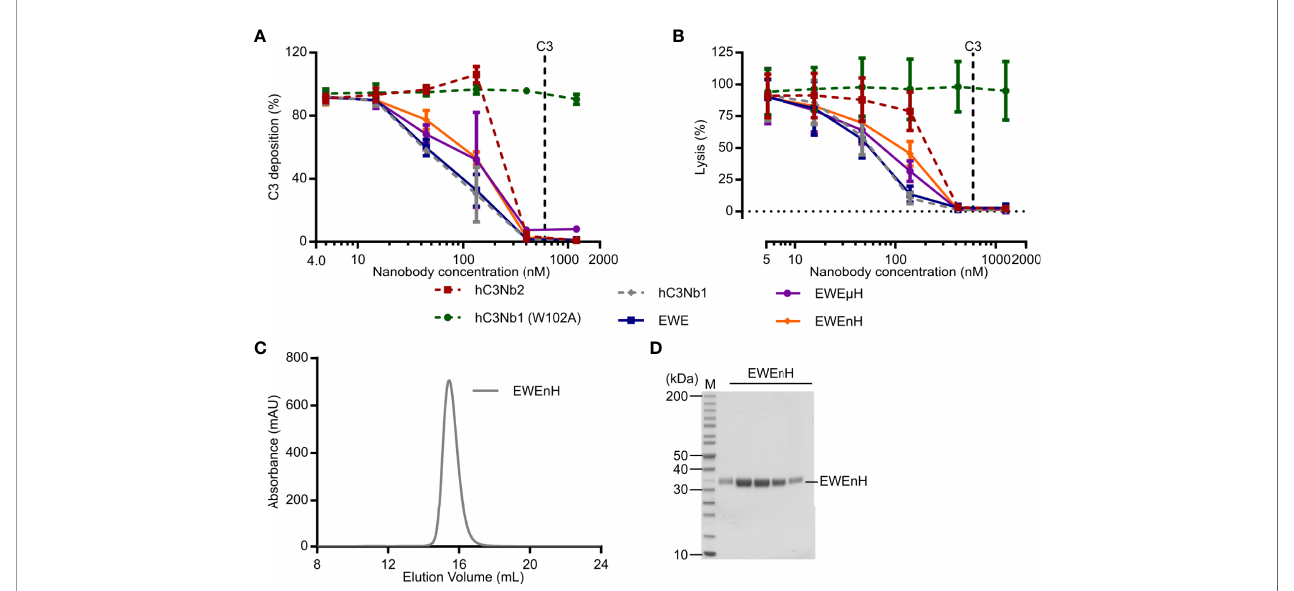
FIGURE 5 | Functional comparison of EWEµH and EWEnH in serum conditions. The effects of EWE, EWEµH, and EWEnH on (A) AP mediated deposition of C3 fragments onto a surface of zymosan or (B) AP mediated hemolysis of rabbit erythrocytes. In panels A and B, the effects were assayed in 11% human serum and data were normalized to 100% in serum without nanobodies, and 0% without serum. The effects were compared to the parental AP inhibitor hC3Nb1 (16), the broad inhibitor hC3Nb2 (22), and the inactive hC3Nb1 (W102A) mutant (16). Dashed lines indicate putative C3 concentrations assuming a C3 concentration of 5.4 µM in undiluted human serum (17). Average and S.D. (error bars) are shown for n=3 experiments in both panels. (C) Ultra fi ltration assay. The EWEnH was concentrated to 22 mg/mL and was subjected to SEC. (D) SDS-PAGE analysis of peak fractions from panel (C) mAU , milli absorbance units. M , molecular weight